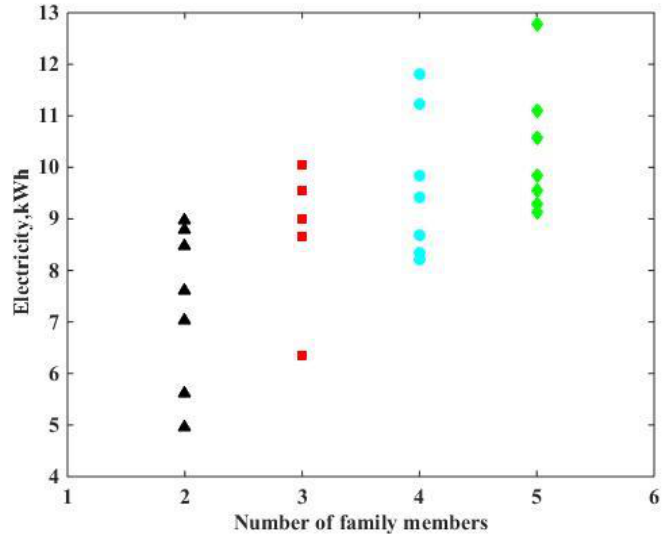
Figure 7. Relationship between power consumption of Eco-cute and number of family members.